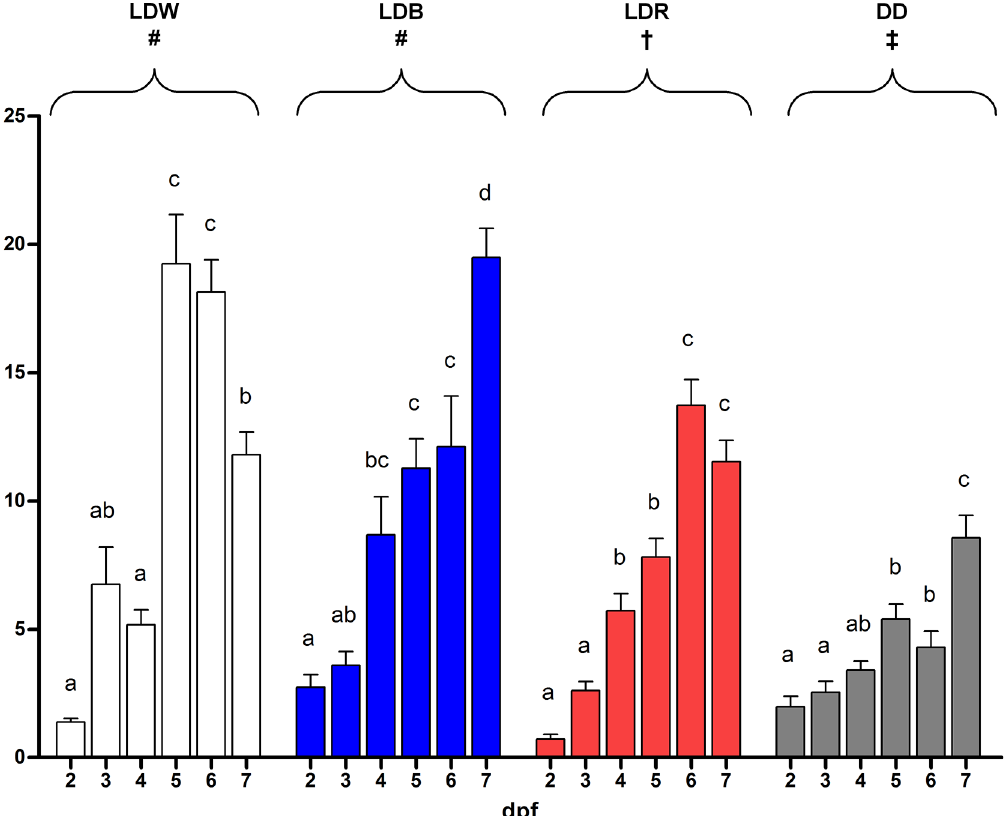
Fig 3. Daily activity under different lighting conditions from 2 to 7 dpf. Data are expressed as mean ± SEM. Letters indicate statistical differences between the different days for each lighting condition (one-way ANOVA; Tukey ’ s post-hoc test, p < 0.05). Symbols indicate statistical differences between the lighting conditions (two-way ANOVA; Tukey ’ s post-hoc test, p <